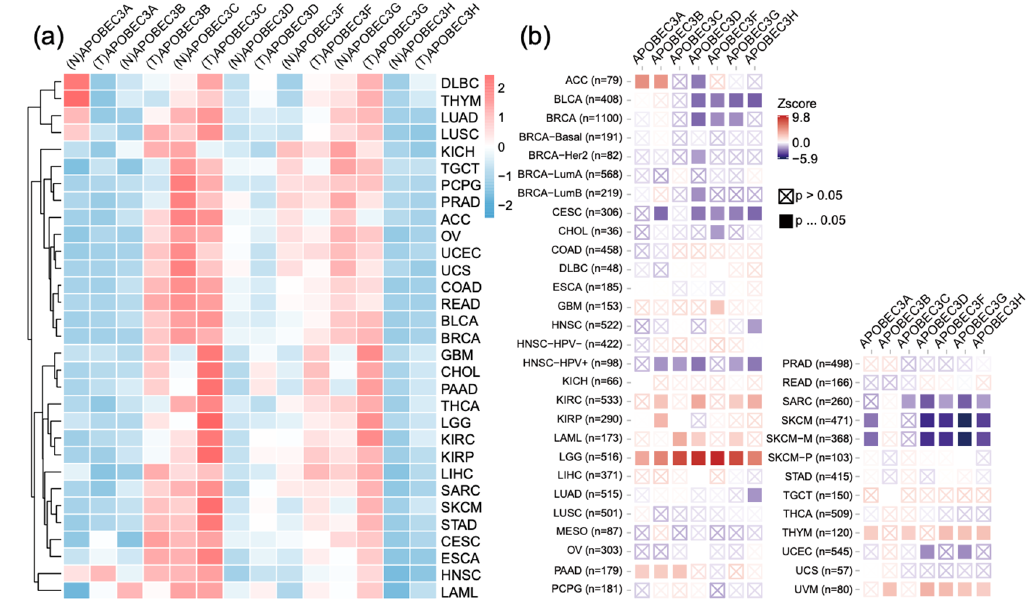
Figure 1. Pan-cancer analysis of the APOBEC3 family expression and survival in TCGA cancers. ( a ) TCGA and GTEx data were integrated to analyze APOBEC3 family expression (TPM) difference between 31 kinds of cancer and normal tissues. ( b ) The relationship between APOBEC3 family expression and survival in 33 TCGA cancers.